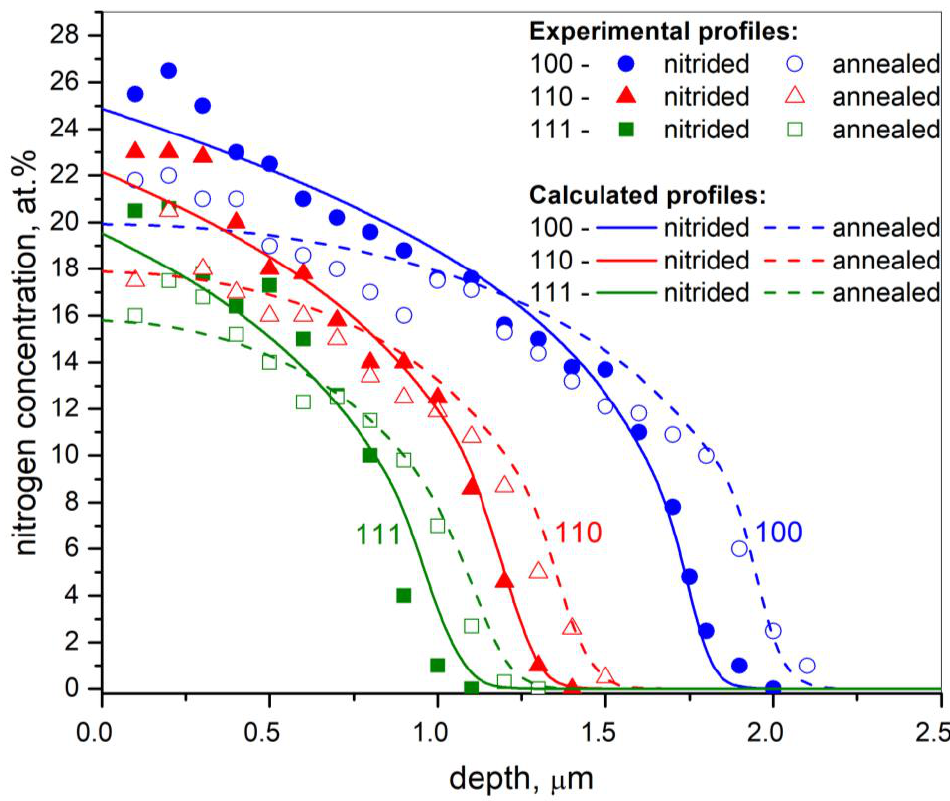
Figure 1. Calculated (lines) and experimental (points, data from [53]) depth profiles of nitrogen in the (100), (110), and (111)-oriented single crystals of ASS. Solid lines: resulting nitrogen profiles after nitriding (for 60 min at 400 °C), dotted lines: resulting nitrogen profiles after isothermal annealing (for 30 min at 400 °C).